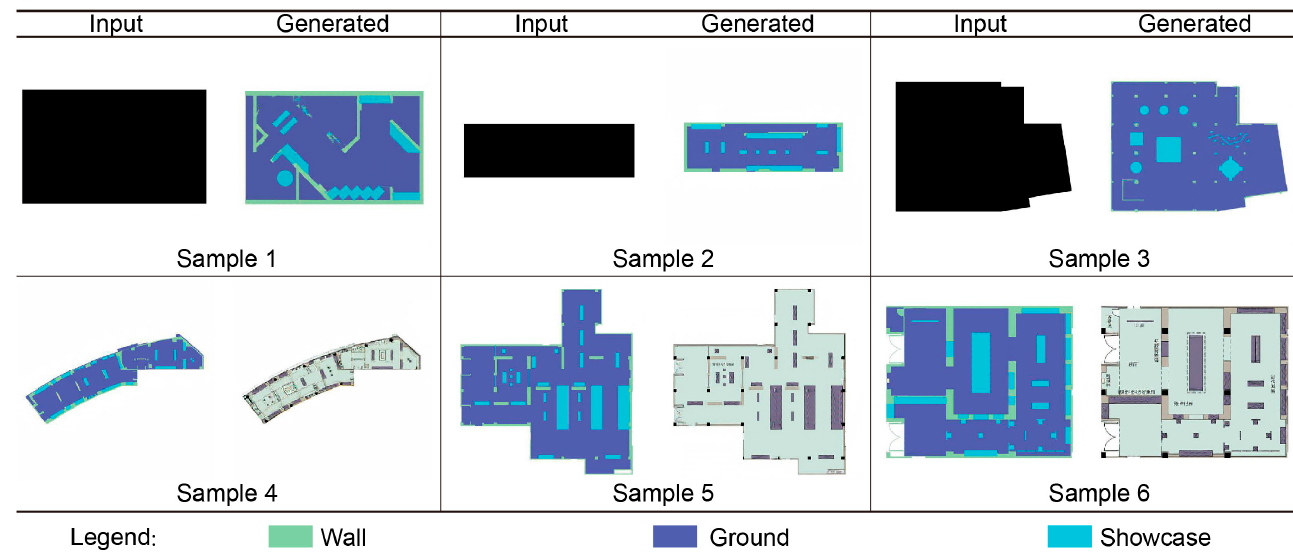
Figure 6. Testing the final model using the training samples (the Chinese annotations in the floor plan represent its spatial function).